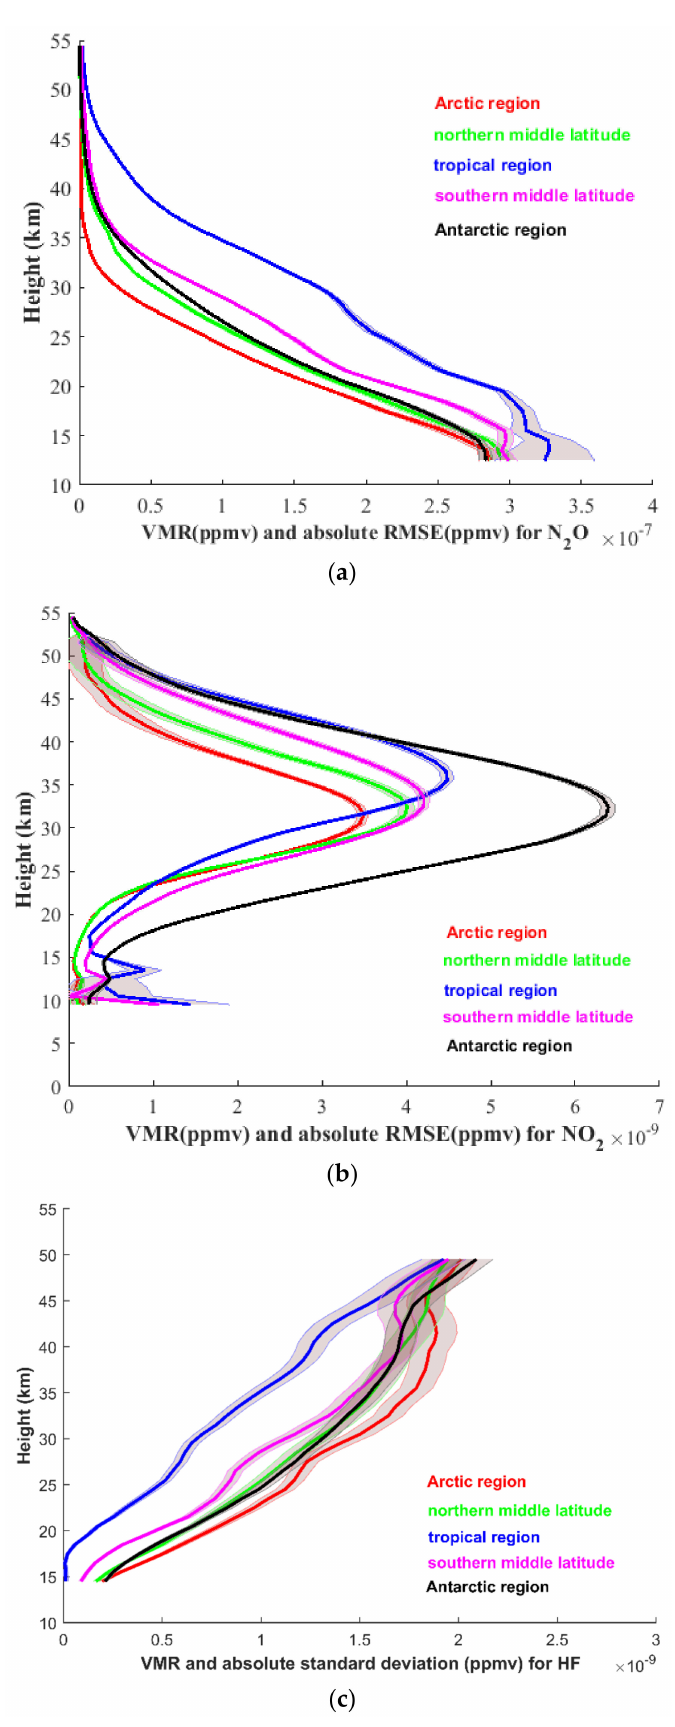
Figure 18. Mean volume mixing ratio (VMR) profiles and absolute standard deviations in five regions. ( a ) For N 2 O; ( b ) for NO 2 ; ( c ) for